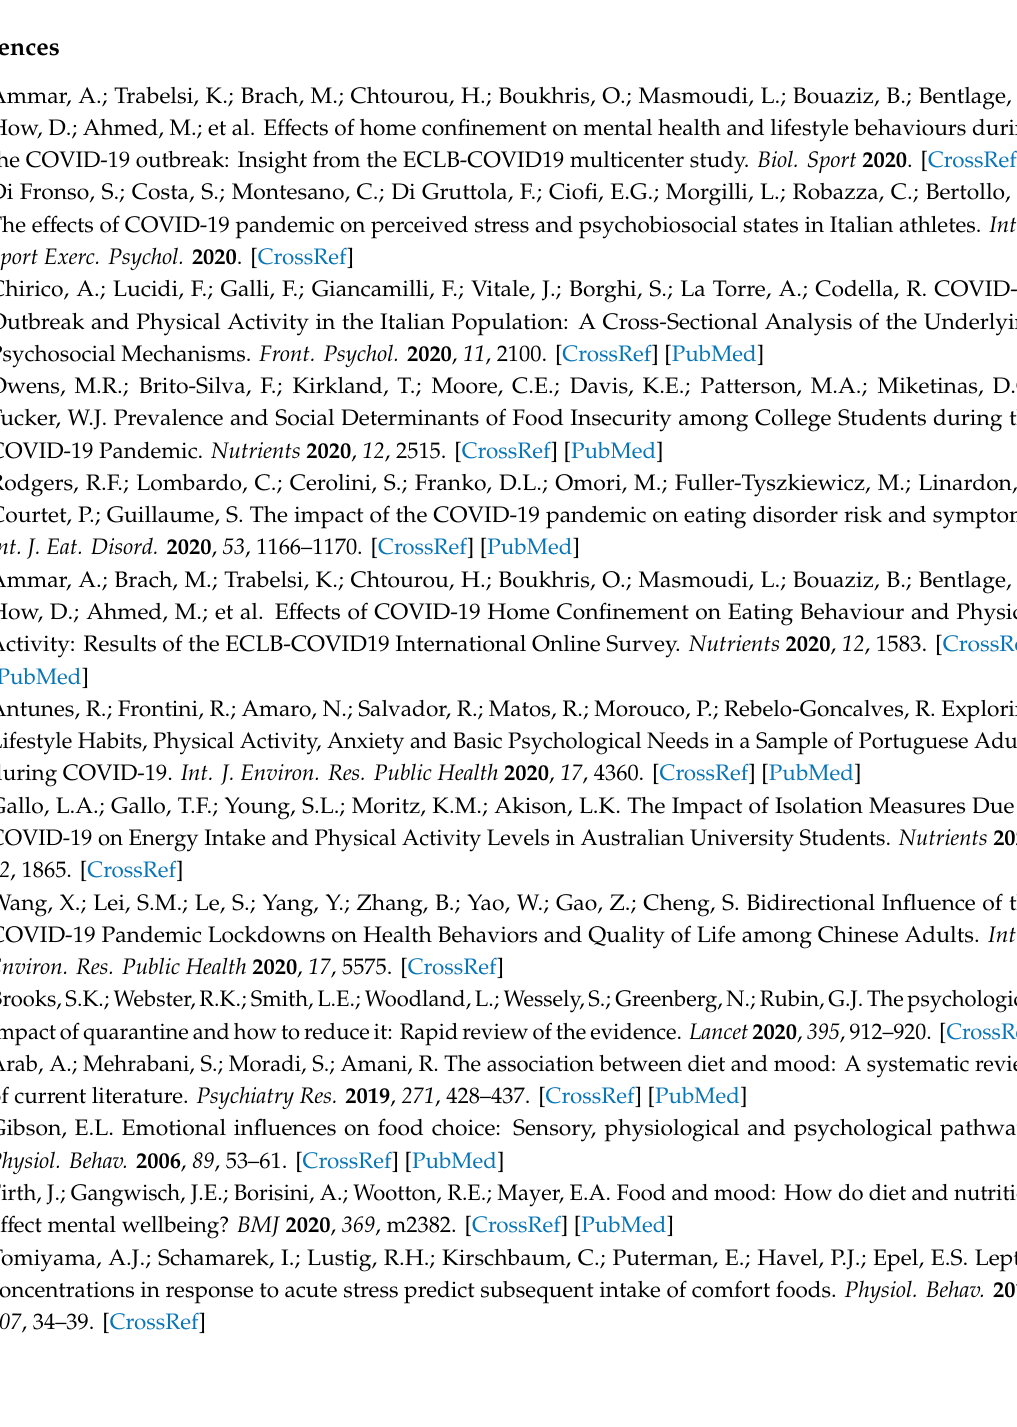
Table S1: Detailed descriptive statistics of the daily nutritional values, split for males and